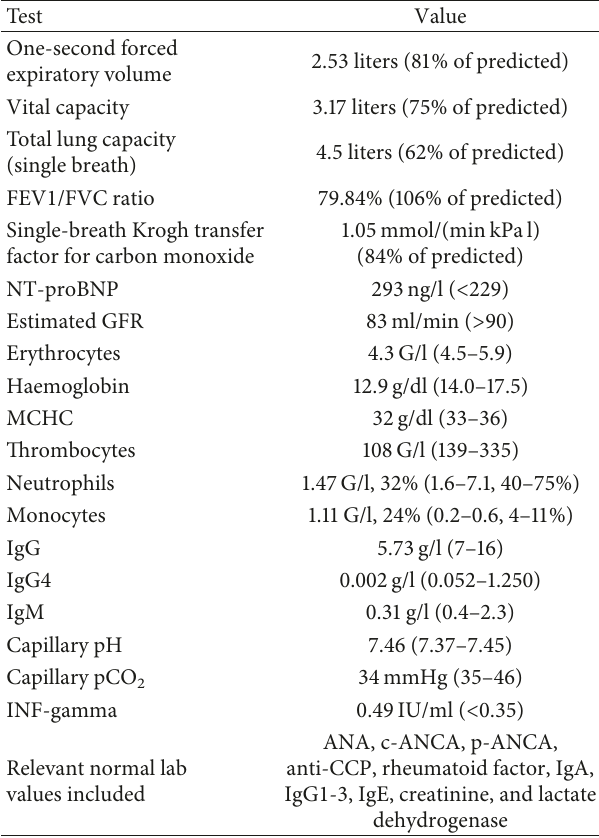
Figure 1: Computed tomography findings. (a) January 2015: the lower lung shows normal lung structures without signs of interstitial pneumonia or fibrosis. (b) June 2015: the same area now shows a bilateral mild interstitial pneumonia with ground-glass opacities. (c) March 2016: images show a more fibrotic structure with mild reticular abnormalities and ground-glass opacities. Table 1: Pulmonary function test and relevant blood values (reference values in